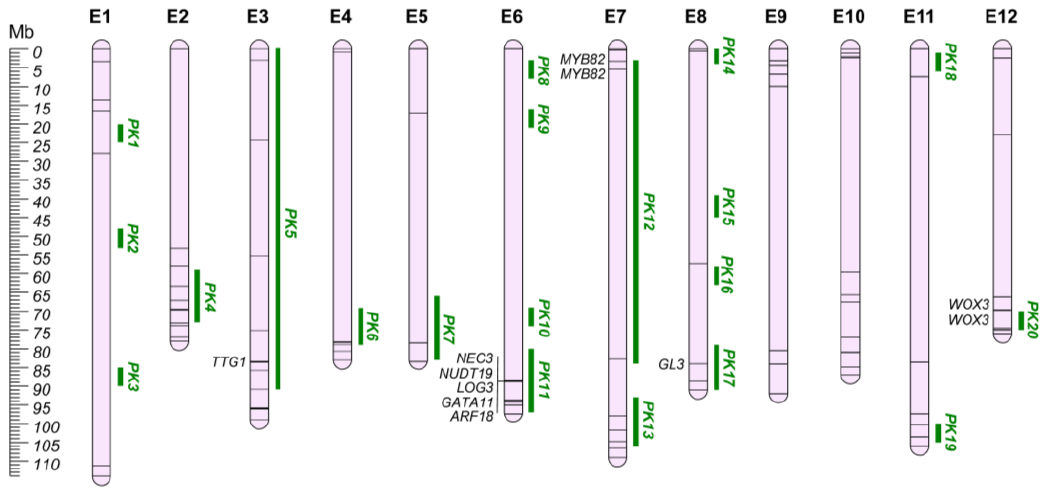
Figure 2. Prickles ’ QGRs (PK; Green) chromosome map (E1 – E12). Main candidate genes are reported in italics, while information about the other candidates (represented by bars on the chromosomes) are shown in Table S3.